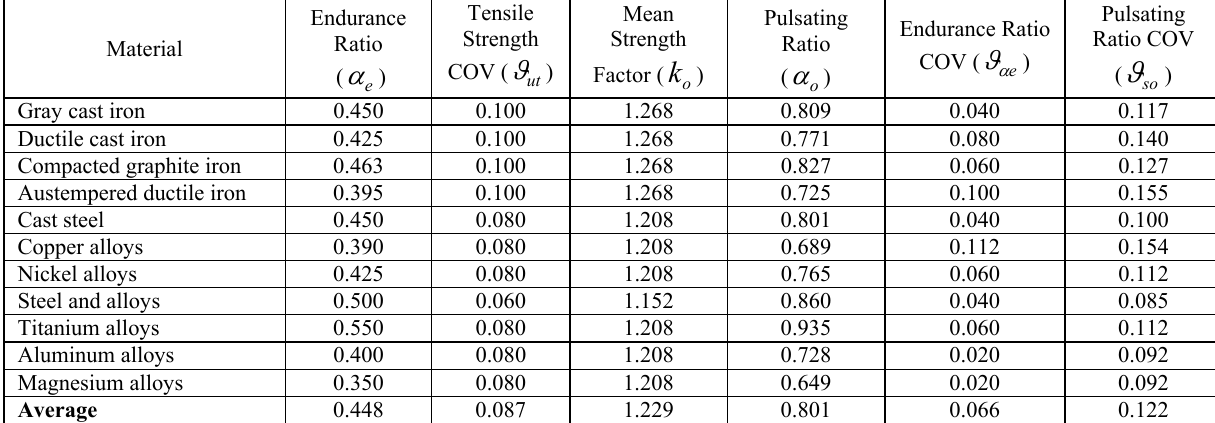
Table A2: Fatigue Ratios of Some Materials at 50% Reliability